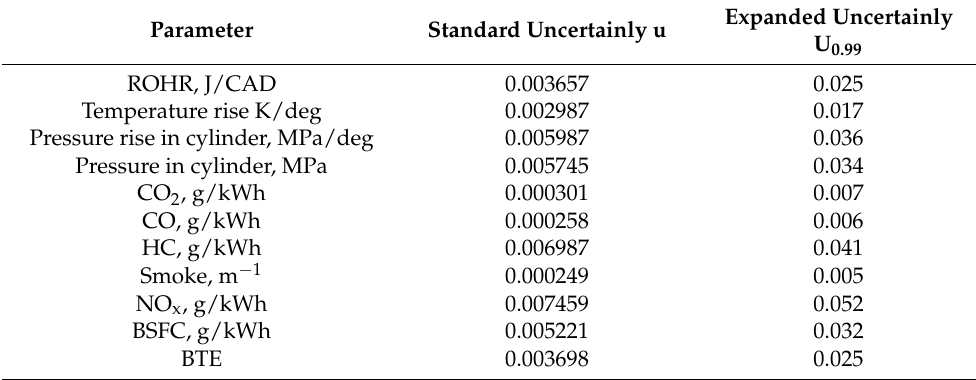
Table 3. The error